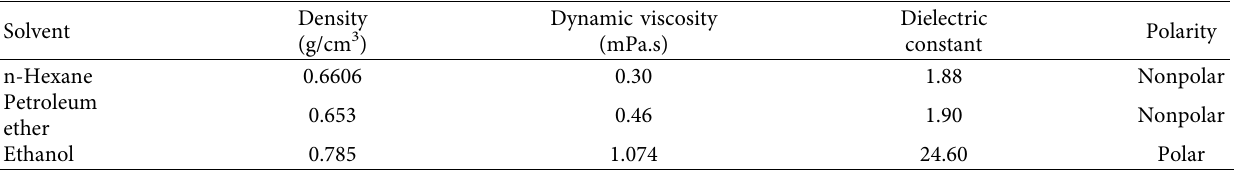
Figure 6: Effect of the type of solvent on oil recovery. Table 1: Some of the important parameters of the solvents studied at 25 °